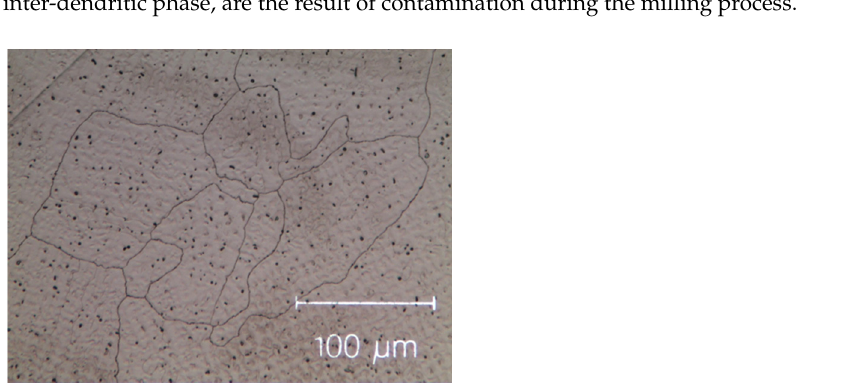
Figure 2. Micro-graph of as-cast Cantor’s alloy Co 20 Cr 20 Ni 20 Fe 20 Mn 20 . Black dots are the result of contamination during the milling process.